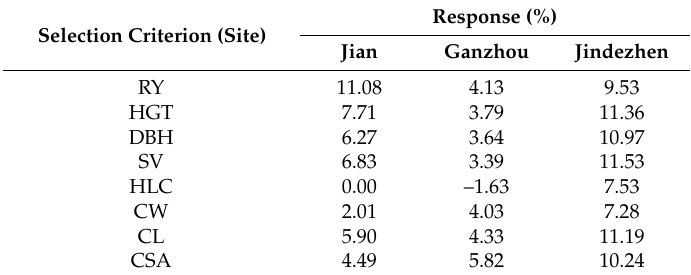
Table 7. Expected response ( ∆ G/x × 100, ∆ G is the genetic gains, and x is the mean values) in resin yield at each site when different selection criteria